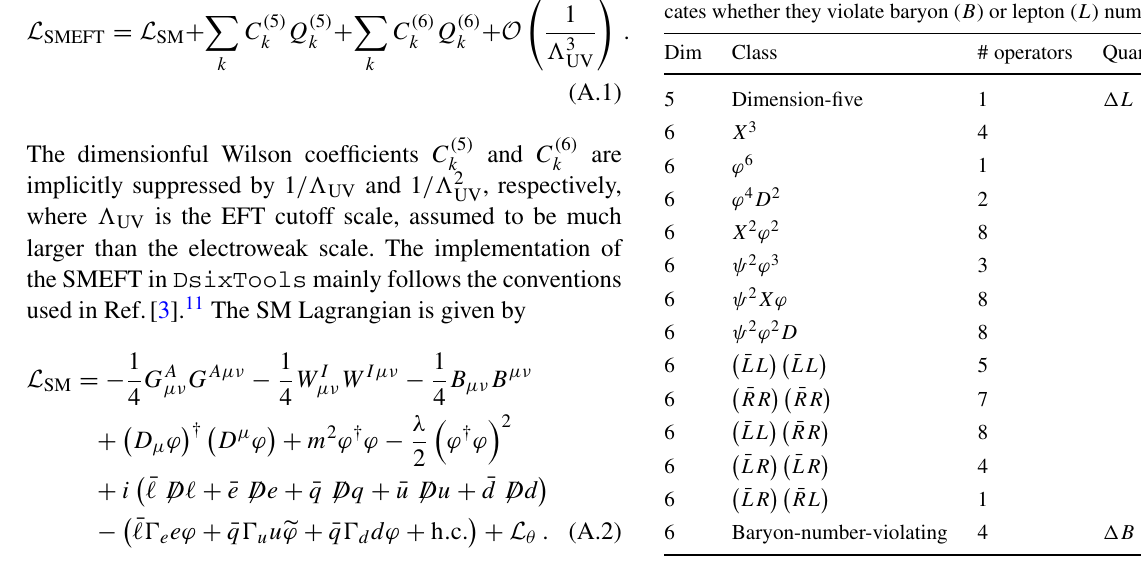
Table 3 SMEFT operators in the Warsaw basis. The third column lists the number of operators in the category whereas the last column